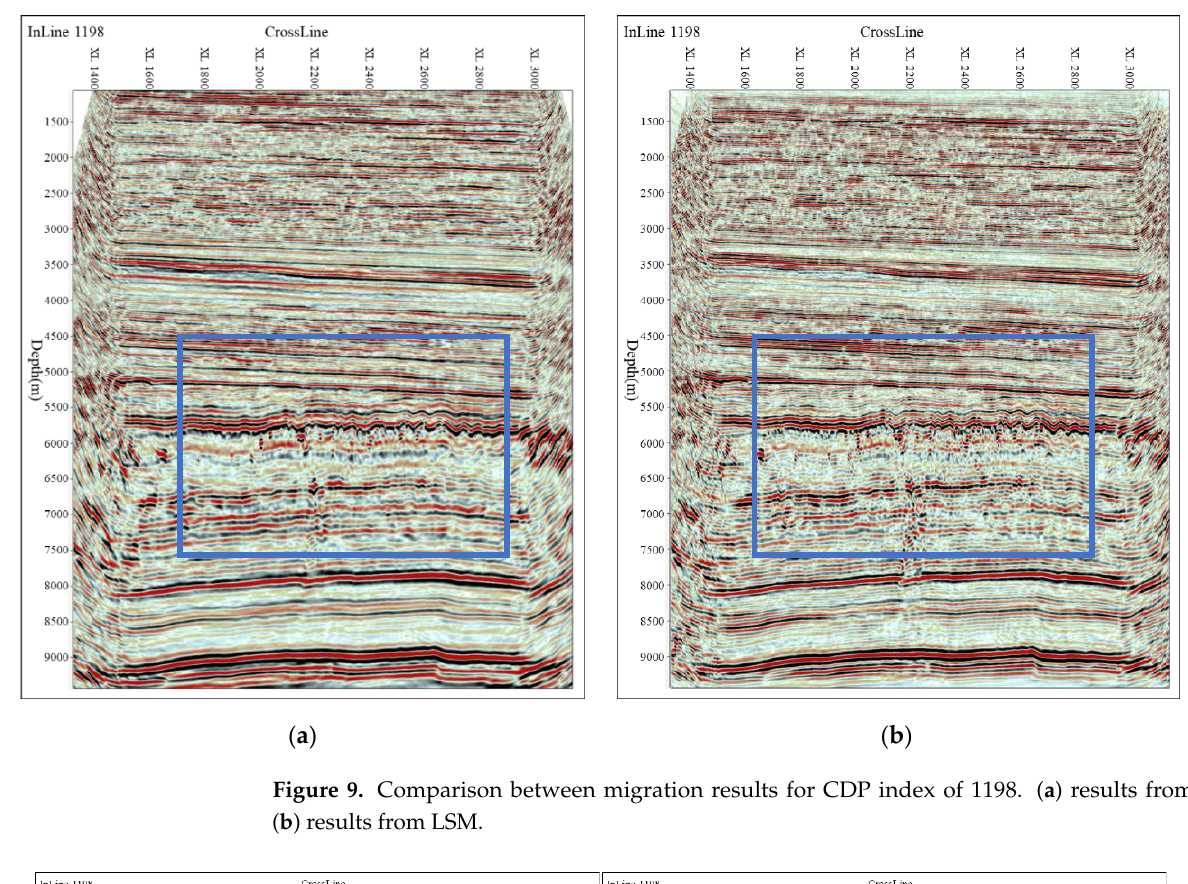
Figure 8. Migration velocity for Tarim oil field.